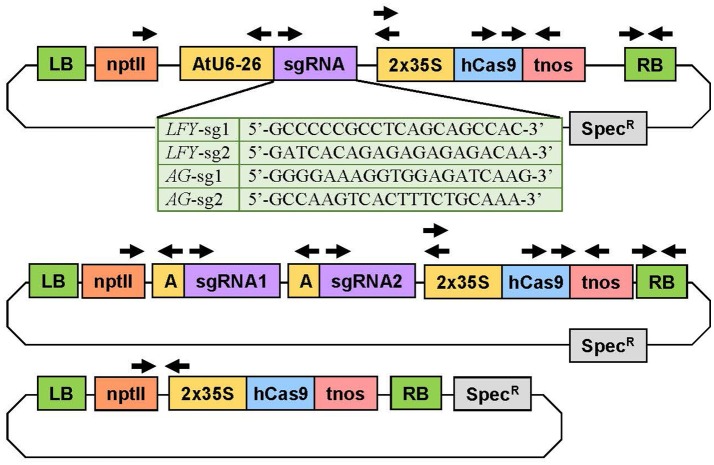
Experimental constructs targeting one or two loci simultaneously. The construct at the top was used to target a single site in the target gene(s). The table below shows the specific sequence of each sgRNA. The plasmid in the middle was used to target two loci in the same gene(s). The plasmid on bottom was the Cas9 control plasmid with no sgRNA. The arrows indicate the primers used to verify the genetic sequence of the plasmids and to determine if the independent insertion events were transgenic. 2X35S, double Cauliflower mosaic virus (CaMV) 35S gene promoter; AtU6-26 or A, Arabidopsis thaliana U6-26 gene promoter; hCas9, human codon-optimized Cas9 gene sequence from Streptococcus pyogenes; LB, left T-DNA border; nptII, neomycin phosphotransferase II gene sequence for kanamycin resistance; RB, right T-DNA border; sgRNA, gene-specific sgRNA sequence; Spec, spectinomycin resistance gene sequence; tnos, termination region of the nopalene synthetase gene from Agrobacterium tumefaciens.